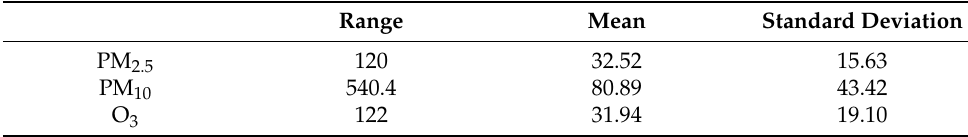
Table 9. Descriptive statistics of O 3 , PM 2.5 , and PM 10